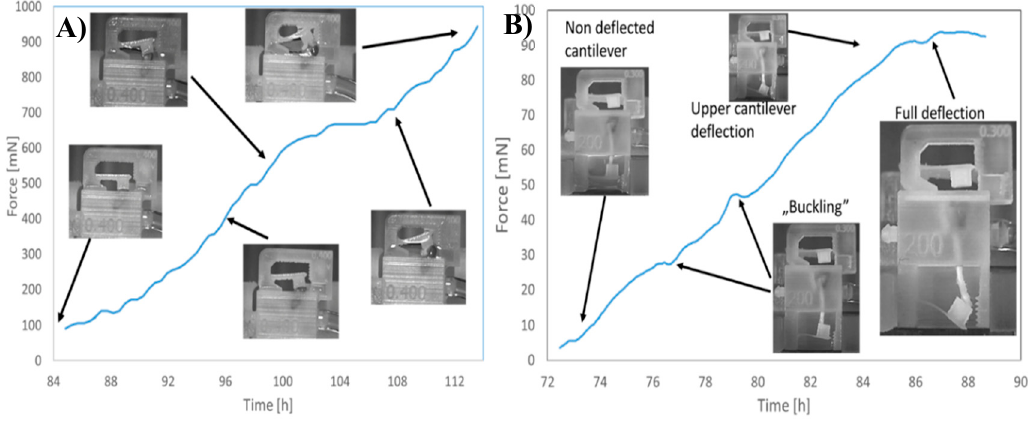
Figure 4. Determined force generated by leaf ( A ) and root ( B ) in function of cultivation time.